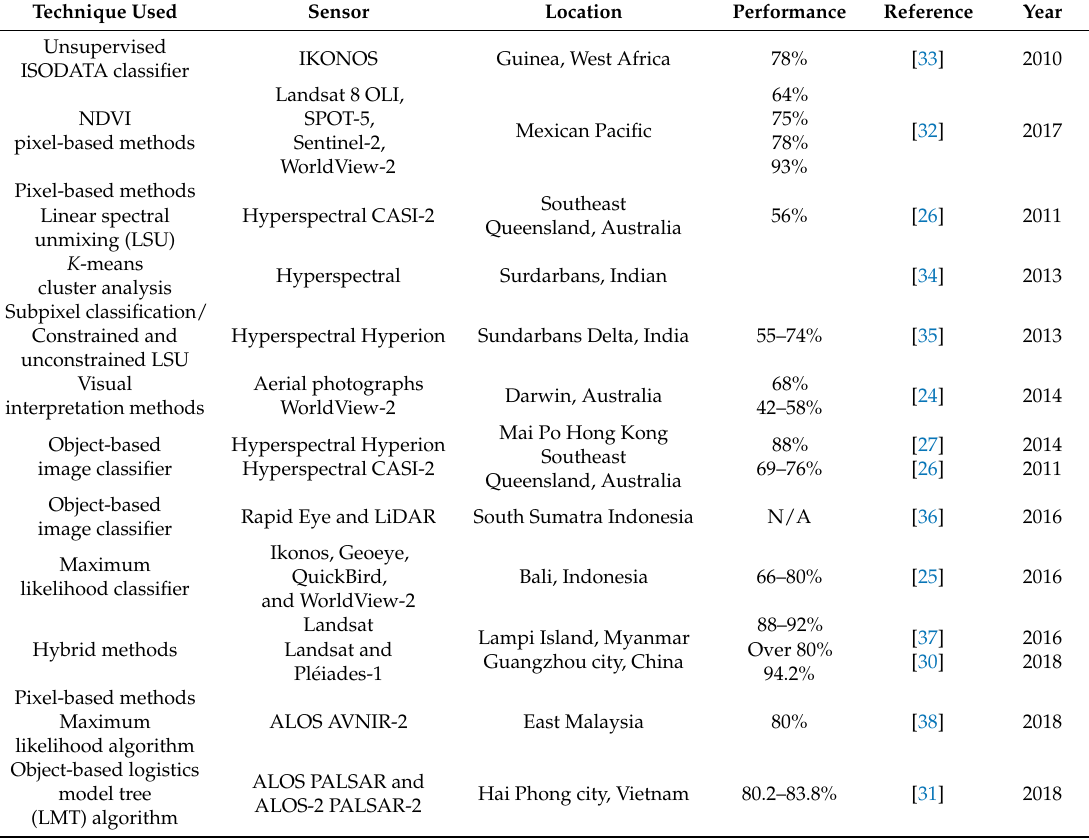
Table 1. Traditional remote sensing approaches to discriminate mangrove